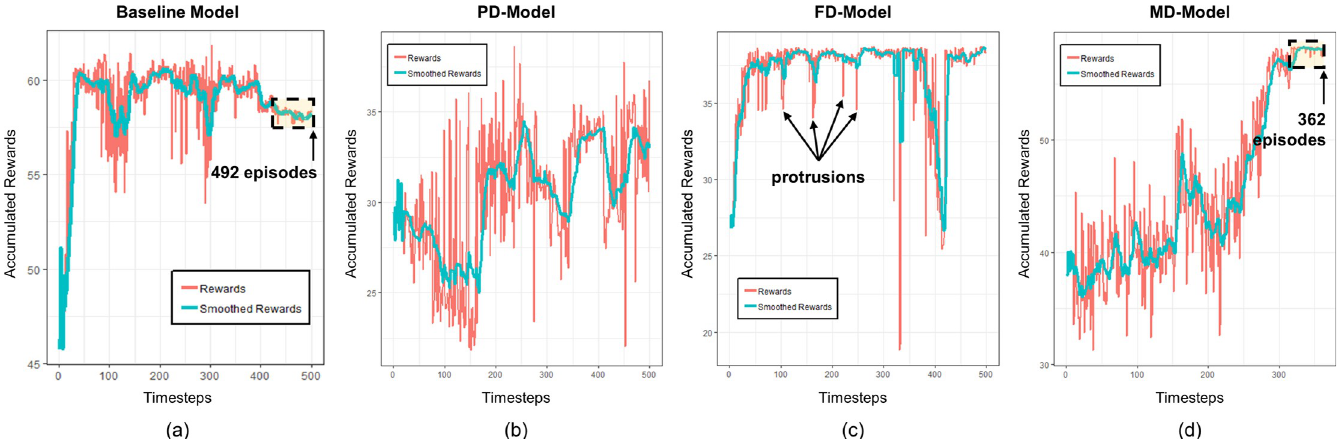
Fig 5. Training results; (a) Baseline model; (b) PD-model; (c) FD-model; (d) MD-model. (Drawn by authors using R program).